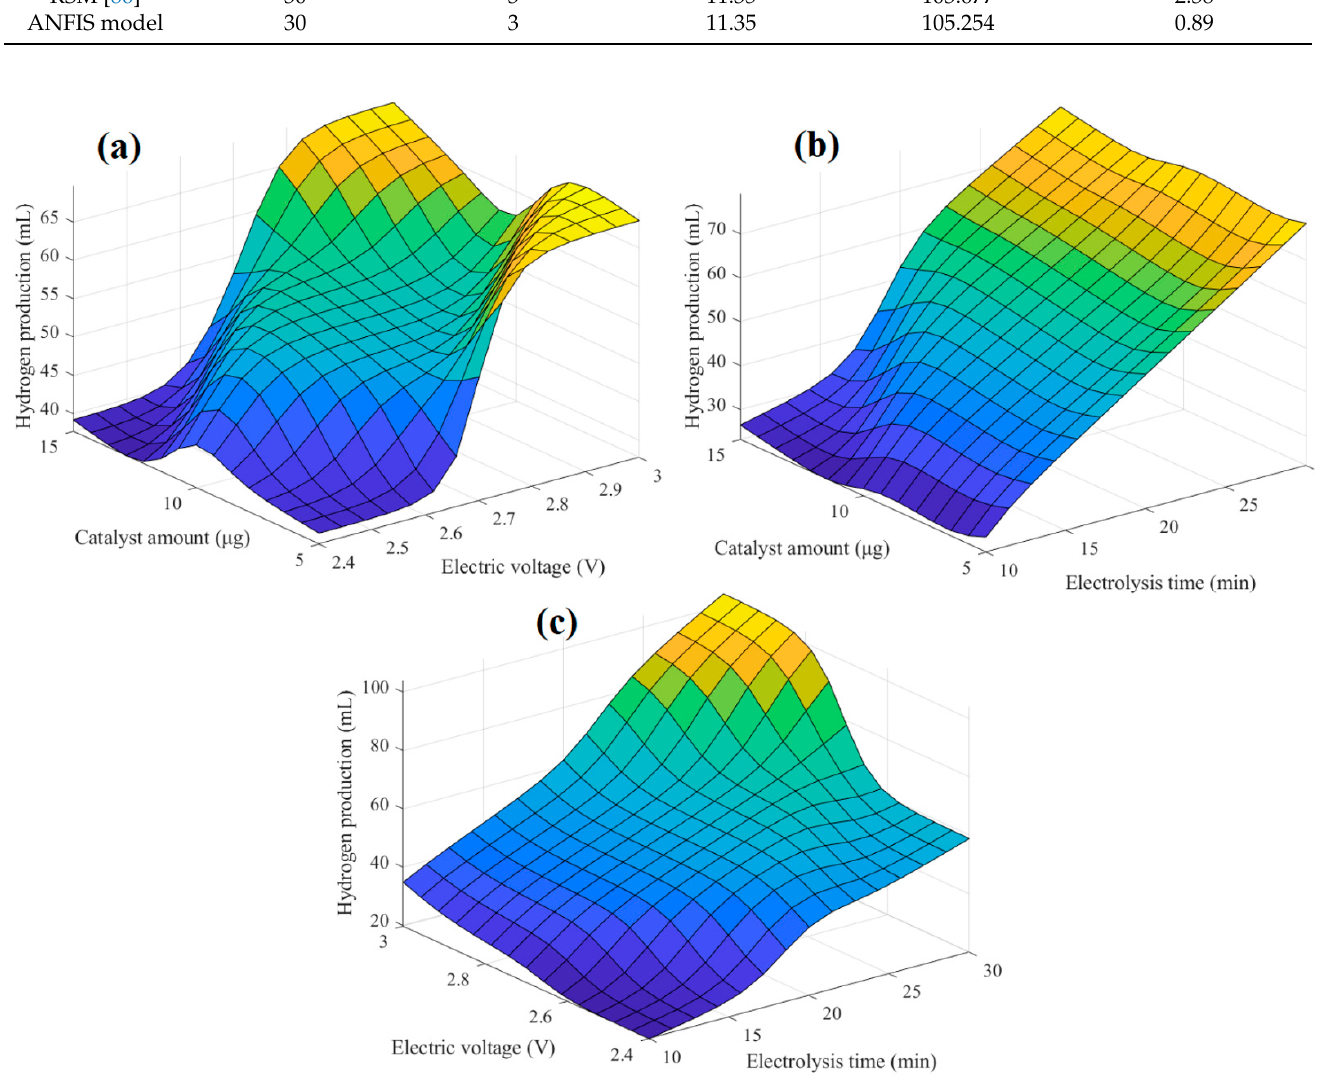
Figure 5. ANFIS surface of the water electrocatalysis process. ( a ) catalyst amount and electric voltage, ( b ) catalyst amount and electrolysis time and ( c ) electric voltage and electrolysis time.